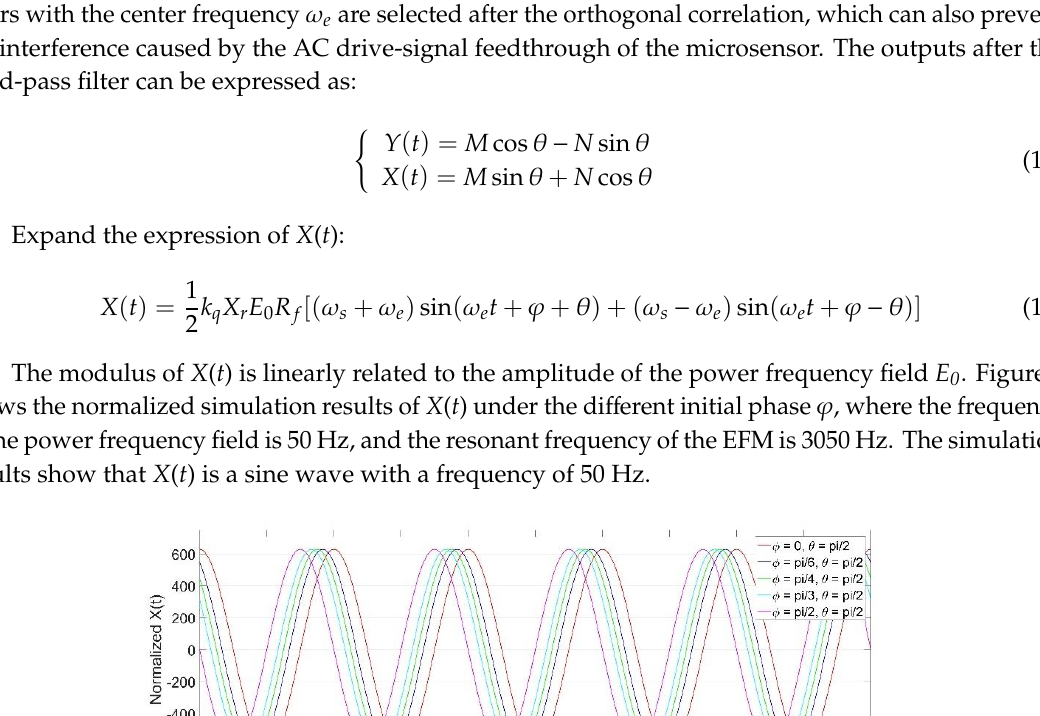
Figure 7. Normalized simulation results of X ( t ) under different initial phase φ values, ω e = 2π 50 rad/s, ω s = 2π 3050 rad/s.